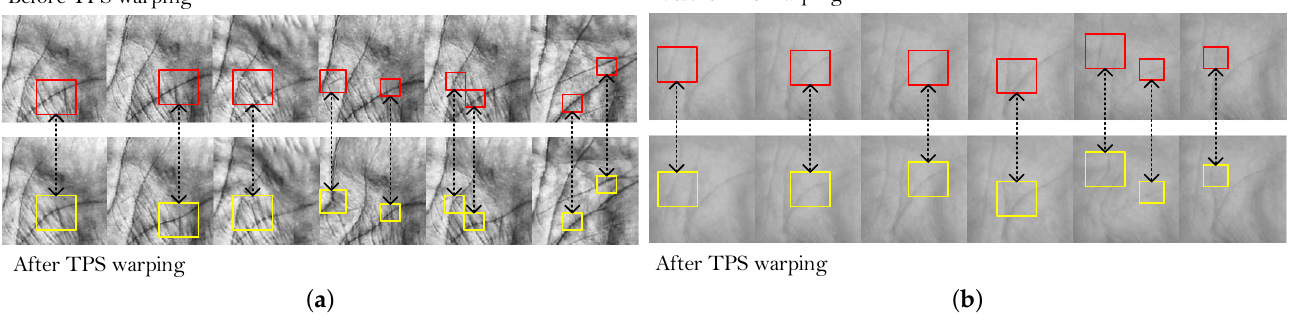
Figure 11. Visual effect of the TPS-based modeling of elastic deformations. Examples are shown before and after the TPS warping on sample images from: ( a ) the IITD dataset and ( b ) the CASIA dataset. The biggest differences after TPS warping are seen in the principle lines. The regions where the principle lines are affected the most by the warping process are marked with rectangles.